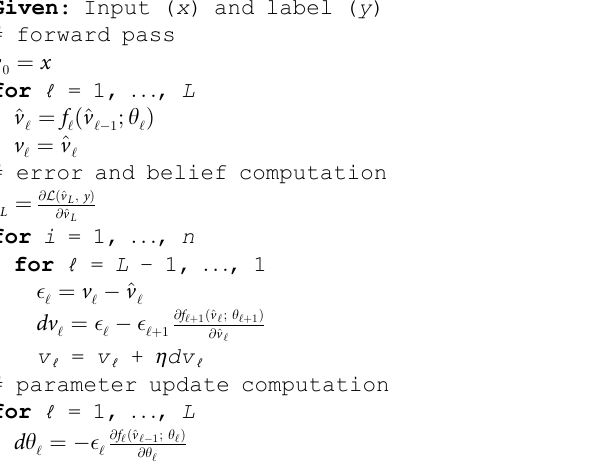
Algorithm 3 Supervised learning with predictive coding modified by the fixed prediction assumption. Adapted from the algorithm in [12] and similar to the algorithm from